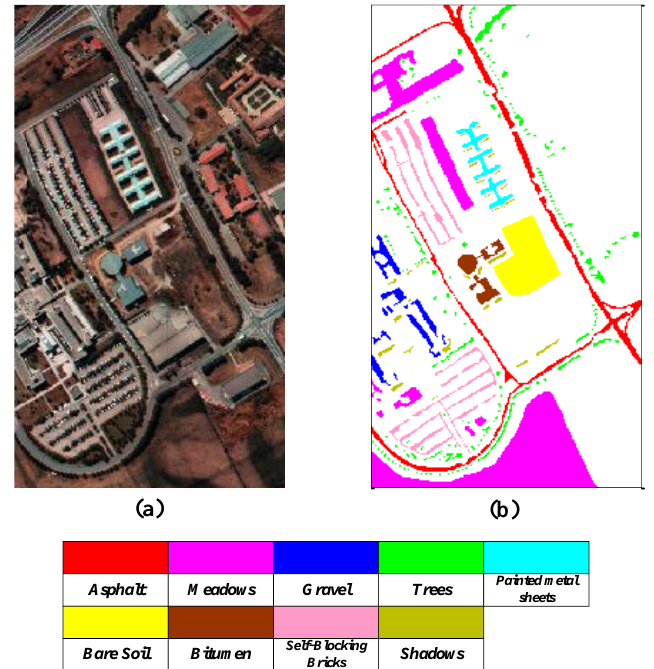
Figure 1. ( a ) False-color image, and ( b ) ground truth map.